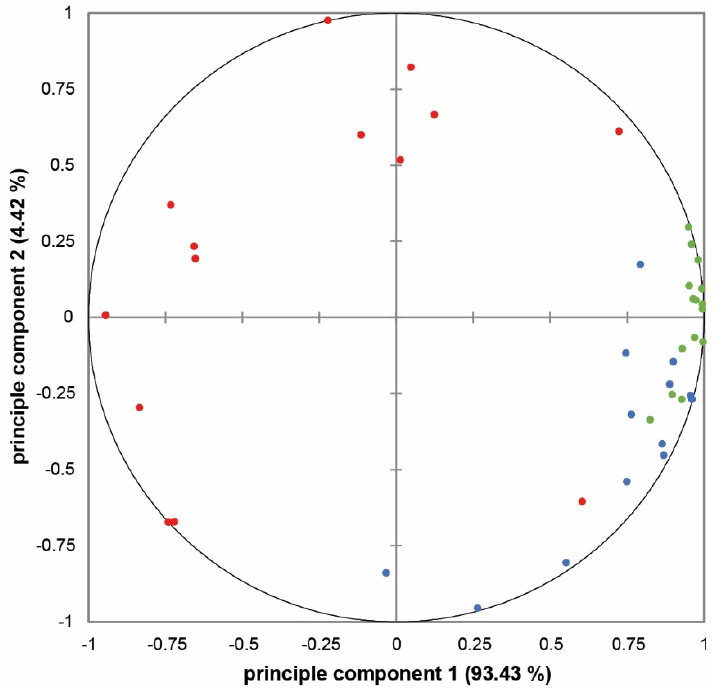
Figure 3. Principle component analysis (PCA) correlation circle: first and second principal components of odour samples ( n = 14). Green = musty, blue = pungent, red = cheesy.